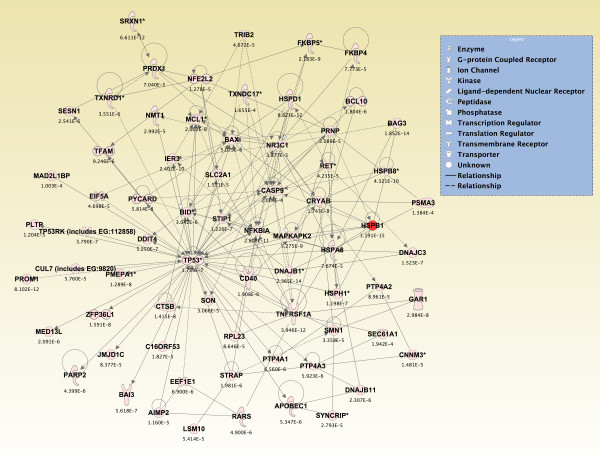
Seizure-induced alteration of cell morphology, cell death, and organismal survival gene network.